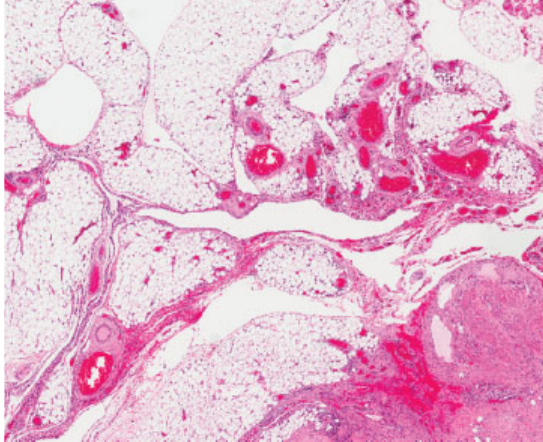
Fig. 2 Photomicrograph of histopathological specimen showing large thin-walled cystic spaces lined with attenuated